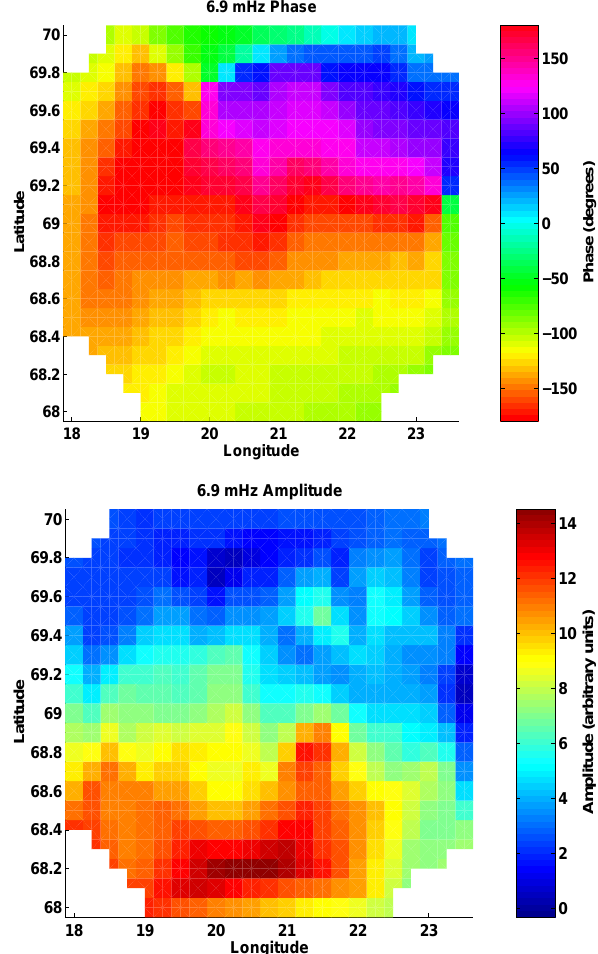
Fig. 4. Maps of the amplitude and phase of Event 1 in IRIS absorp-